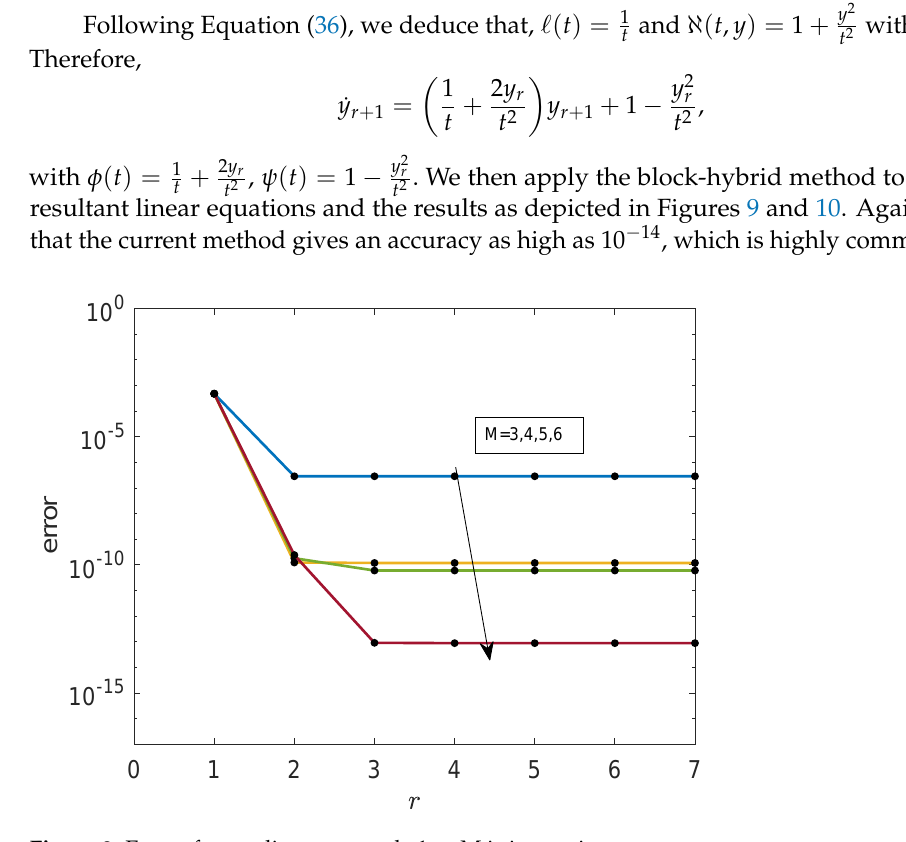
Figure 9. Errors for nonlinear example 1 as M is increasing.